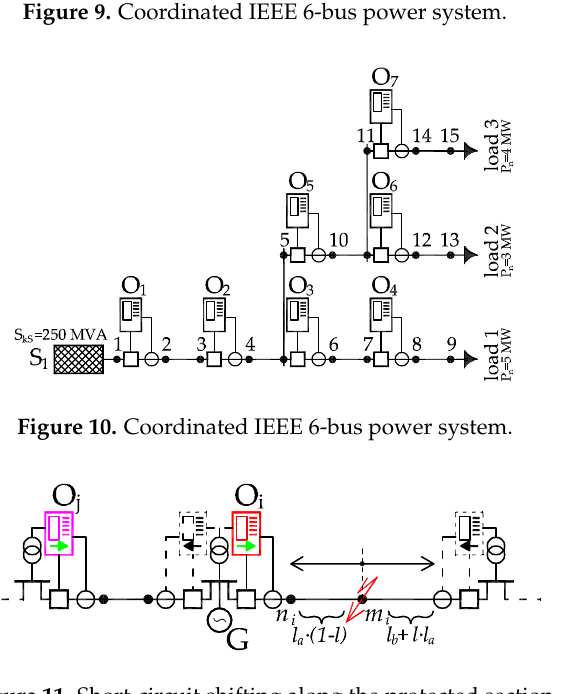
Figure 11. Short-circuit shifting along the protected section.